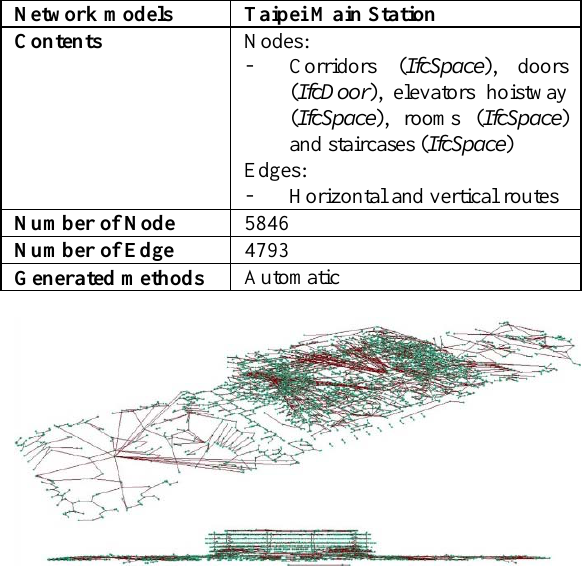
Table 2. The summarization of network model